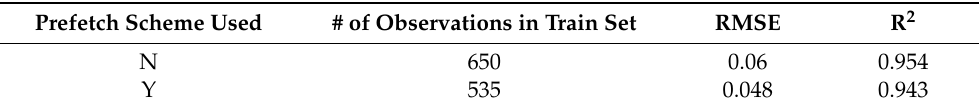
Figure 15. RMSE for train and test sets over 25 epochs with the usage of the proposed prefetch scheme. After usage of the prefetch scheme, the train set was reduced by 20%. Table 1. RMSE and R 2 of the LSTM network with and without the usage of the proposed prefetch scheme. Prefetch Scheme